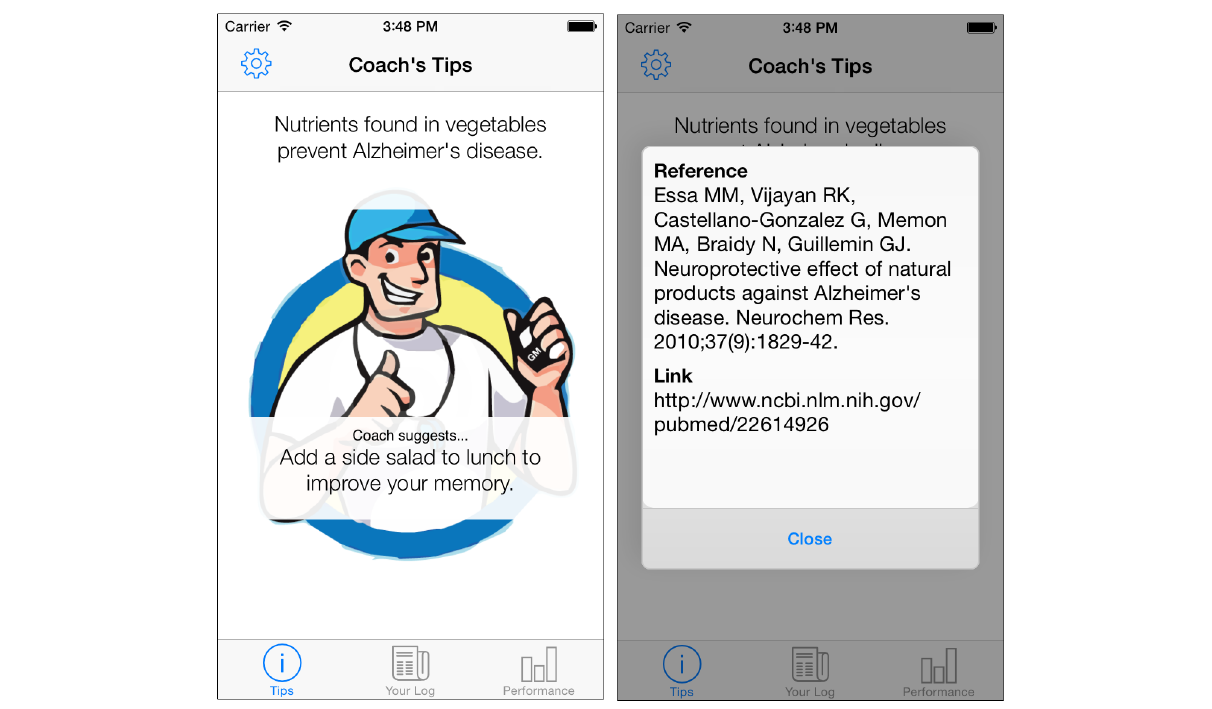
Figure 2. Tips tab main screen showing daily fact (fact and suggestion pair; left). Evidence-based literature reference and link are displayed when the fact section of the daily fact is tapped